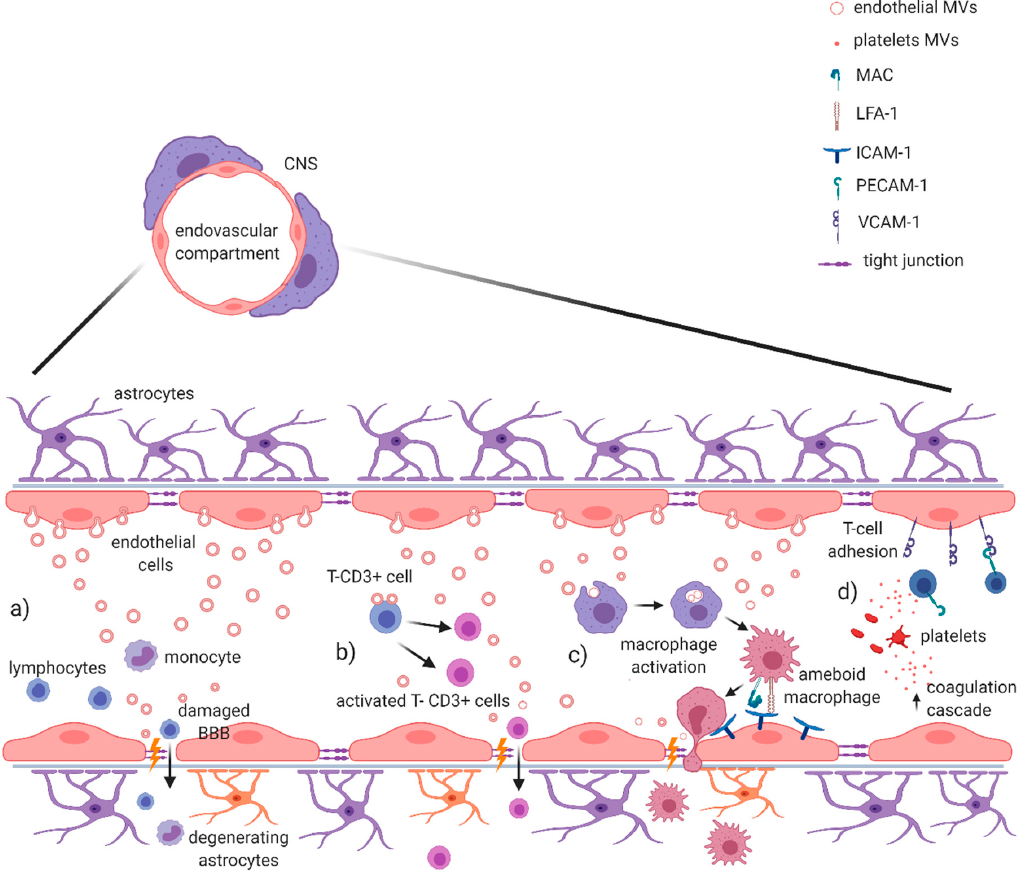
Figure 1. EV-mediated blood–brain barrier dysfunction in MS and EAE. It has been demonstrated that EVs are capable of damaging the integrity of blood–brain barrier during active phase of MS. ( a ) In the endovascular compartment, endothelial EV production directly promotes the disruption of extracellular matrix and tight junctions, allowing the passage of leukocytes through BBB. ( b ) Endothelial EVs are also directly involved in the activation of T-CD3 + cells, contributing to the BBB damage. ( c ) Other evidence suggests a role in monocyte / macrophage activation, with the expression of Mac and LFA-1 integrins that promote transendothelial migration of activated macrophages. ( d ) Platelet-derived MVs contribute to enrich local inflammatory milieu, with an activation of coagulation cascade mediated by thrombin; at the same time, they help lymphocyte adhesion on endothelium binding CD31 / PECAM-1 and increase the expression of VCAM-1, further contributing to the BBB damage. Figure created with BioRender.com.